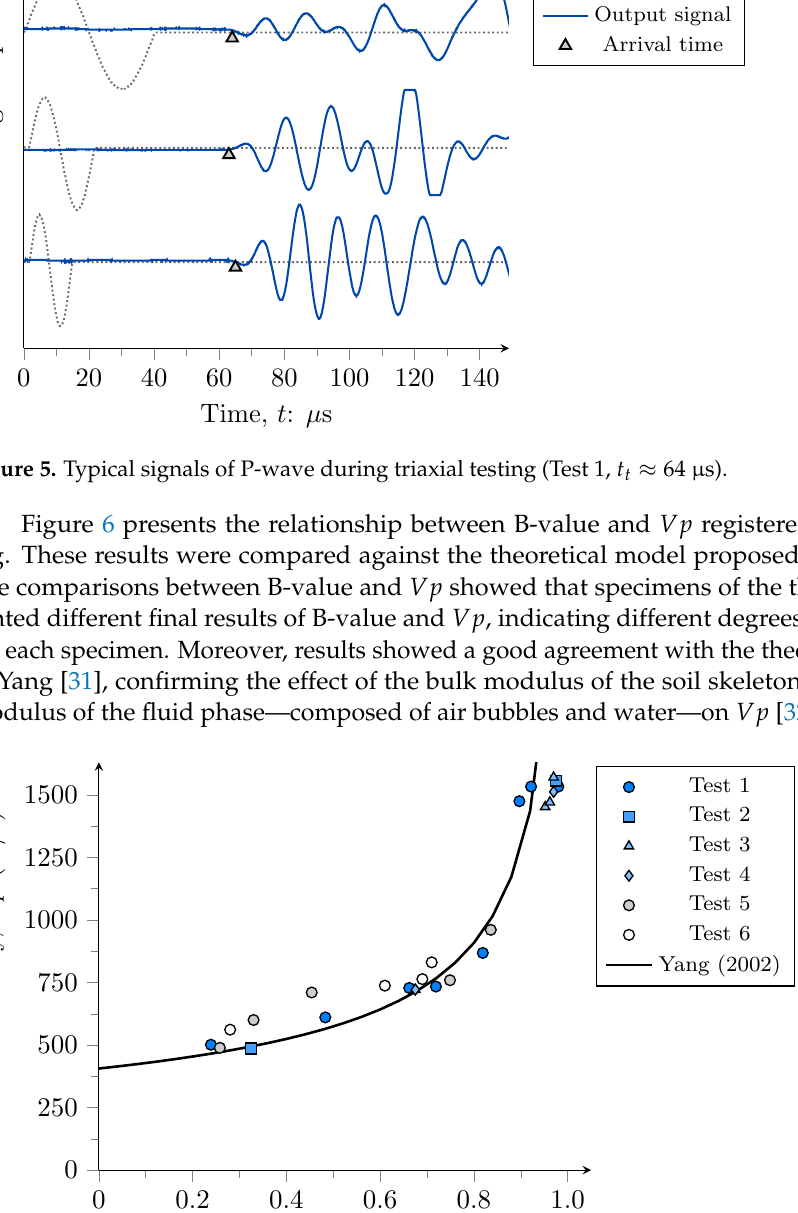
Figure 6. Relationship between B-value and Vp